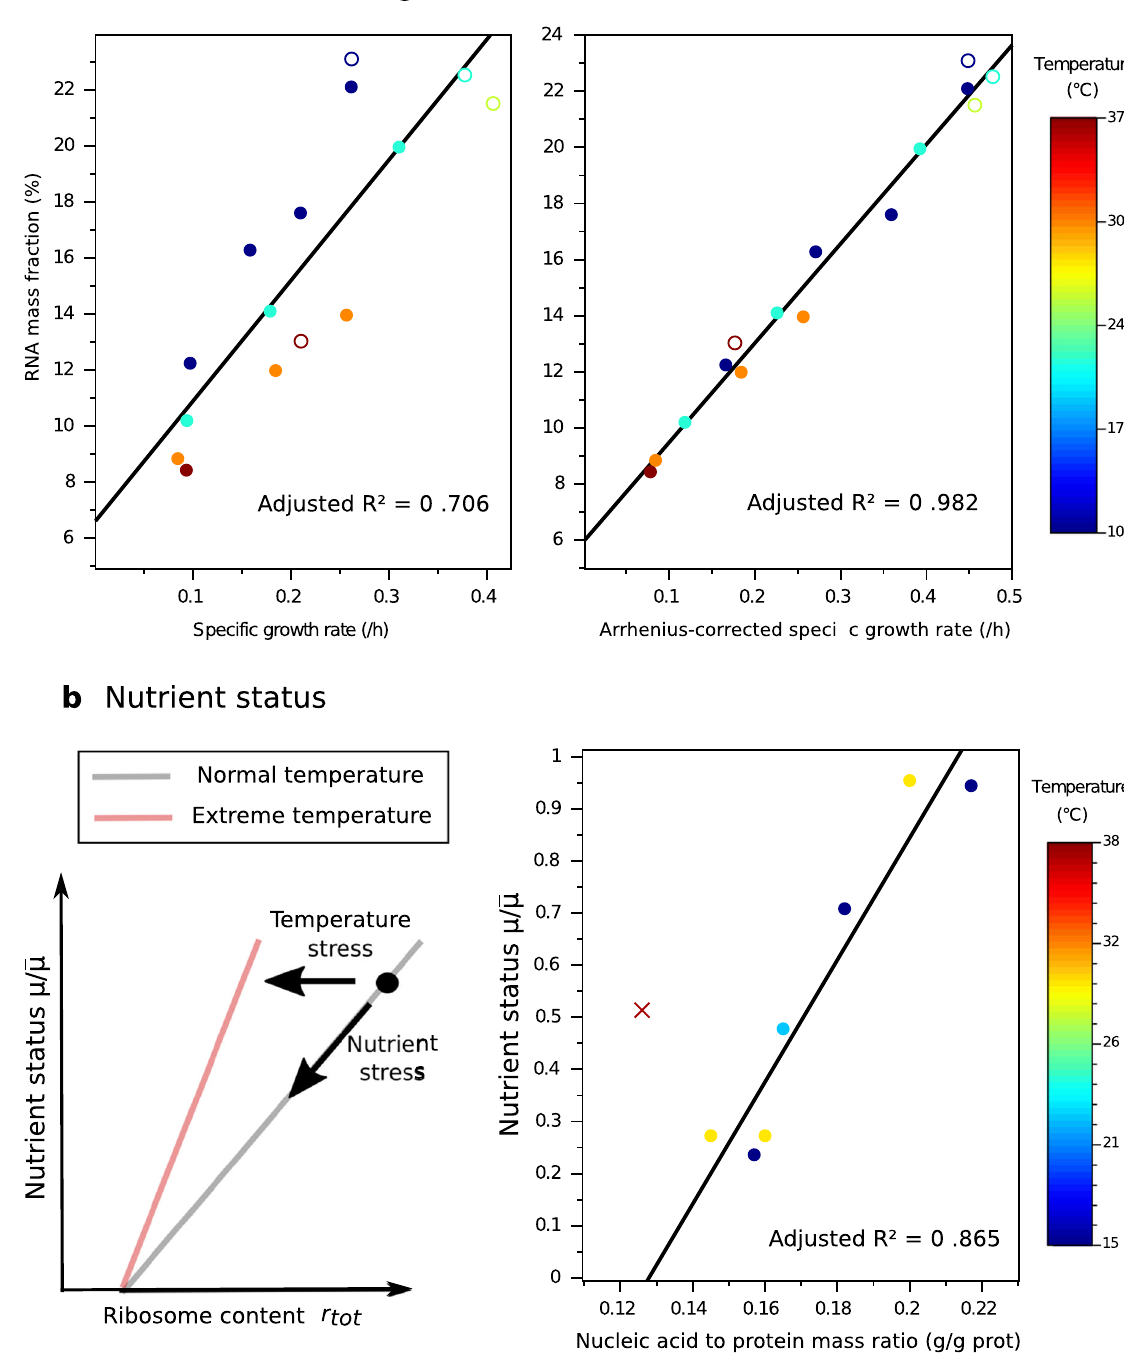
Fig. 4 Microbial growth laws accounting for temperature effects. a Growth law between growth rate and RNA content, without (left) and with (right) Arrhenius correction (Eqs. (9) – (10)) for S. cerevisiae 24 . The Arrhenius correction greatly improves the linear regression, as witnessed by the increase of adjusted R 2 from 0.706 to 0.982. Open symbols: batch; closed symbols: chemostat. For each point, color represents temperature (see colorbar). b Nutrient status as a function of the ribosome content. Left: the gray line represents the theoretical relationship valid for non-extreme temperatures (from Eq. (12)). At extreme temperatures, the slope changes due to chaperone burden (Eq. (11)). A decrease in ribosome content relative to a control (black dot) could be due to a substrate limitation and/or temperature stress. Right: nutrient status as a function of the nucleic acid to protein ratios for Candida utilis 43 . The only point above the optimal temperature for growth, marked by x, was identi fi ed as an outlier and removed from the linear regression, showing a possible effect of temperature stress in line with our